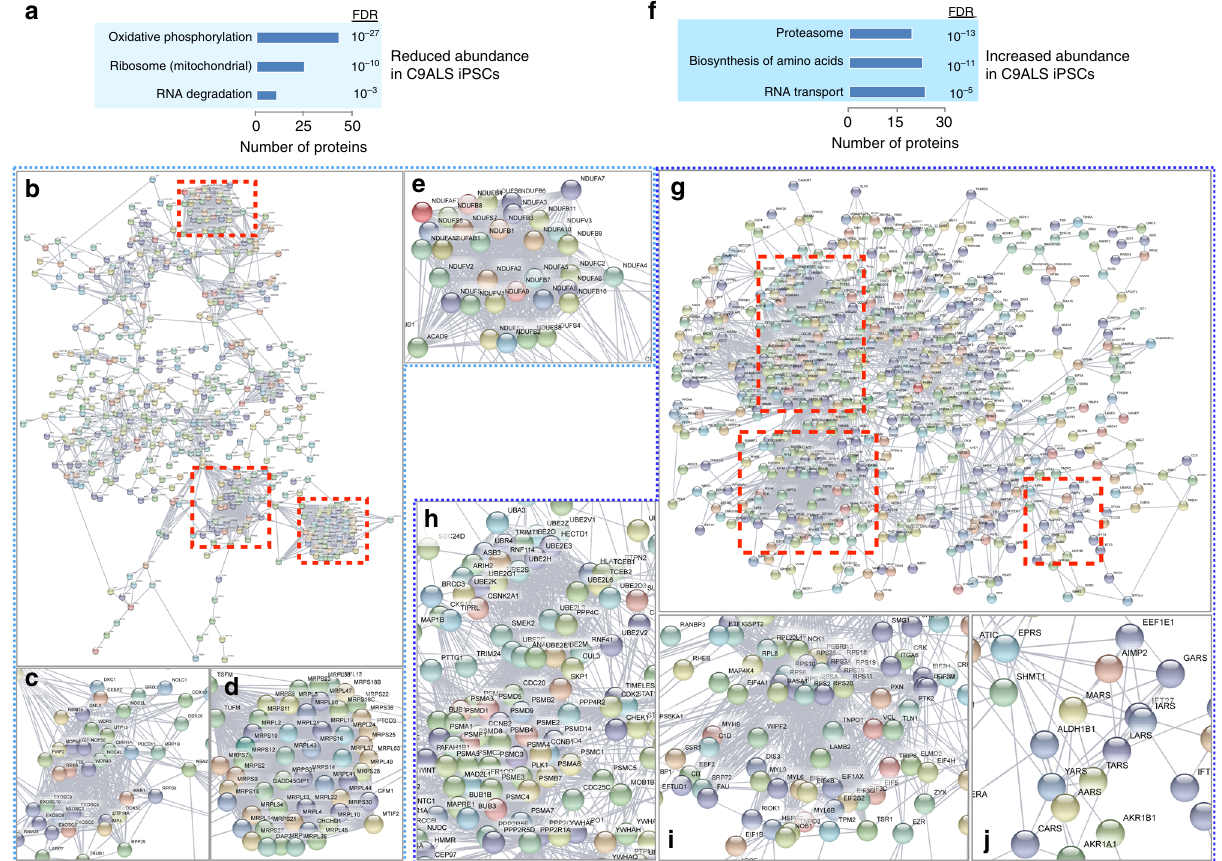
Fig. 6 Unbiased proteomics con fi rms mitochondrial protein de fi cit in C9ALS iPSCs. Gene ontology ( a ) and STRING analysis ( b ) for the 806 proteins reduced ≥ 10% in C9ALS iPSCs, demonstrating enrichment for components of oxidative phosphorylation, mitochondrial ribosome, and RNA degradation pathways. Higher magni fi cation views of boxed clusters in b are shown in c − e . Gene ontology ( f ) and STRING analysis ( g ) for the 961 proteins increased ≥ 10% in C9ALS iPSCs, showing enrichment for components of the proteasome, amino acid biosynthesis, and RNA transport pathways. Higher magni fi cation views of boxed clusters in g are shown in h − j . FDR false discovery rate. All experiments performed in triplicate with two